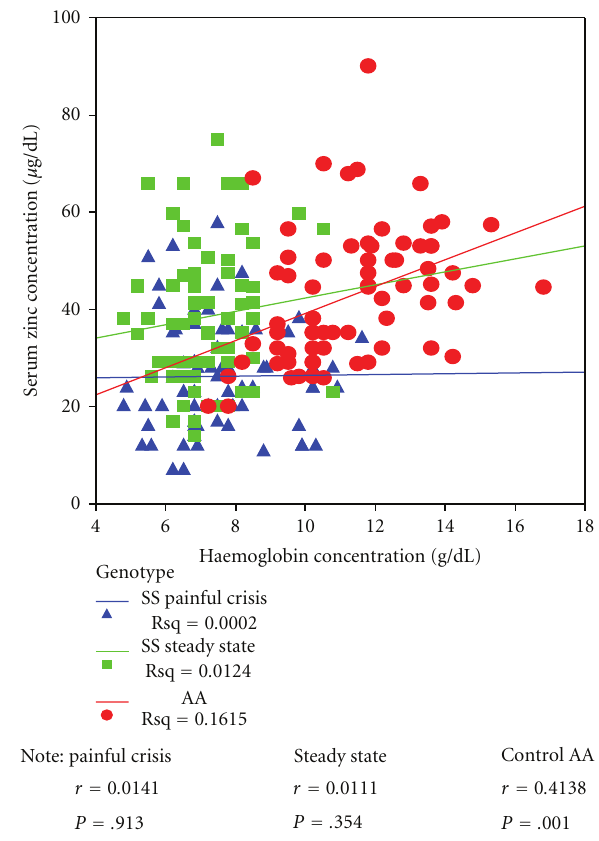
Figure 2: Linear relationship between haemoglobin concentration to serum zinc levels in Control, SCA in steady state, and SCA in painful